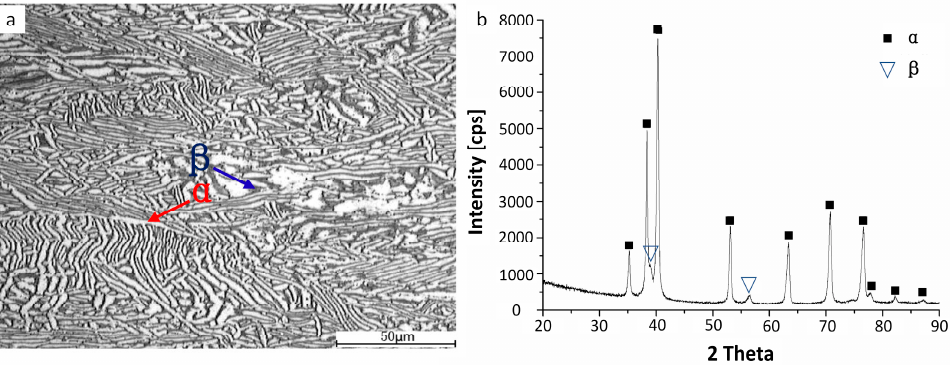
Figure 3. Microstructure and phase composition of base metal: ( a ) optical microscopy; ( b ) X-ray diffraction pattern.